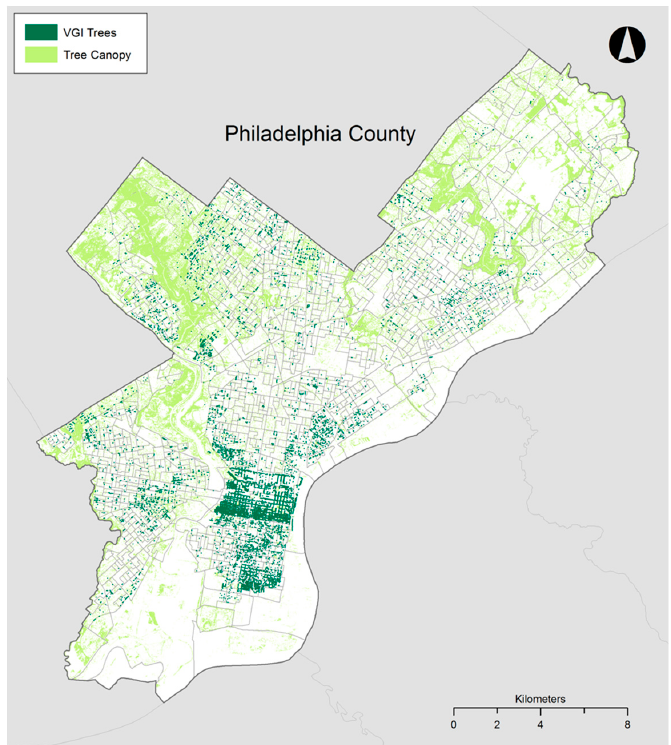
Figure 1. Philadelphia tree canopy and all tree points.